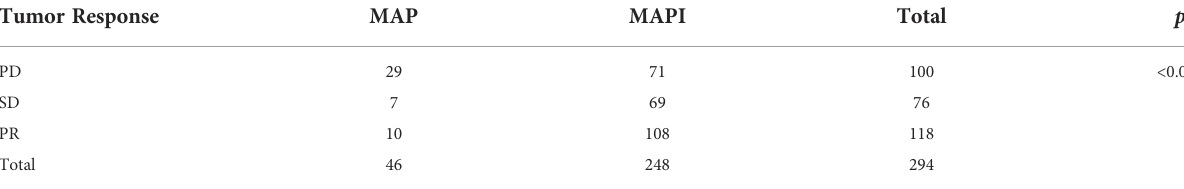
TABLE 2 Statistical analysis of effects of IFO on tumor response before and after neoadjuvant chemotherapy. Tumor